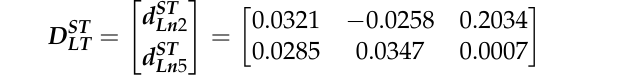
Table 5. The parameter of the Cable280 unit. Parameter Density (kg/m 3 ) Value 1800 28,000